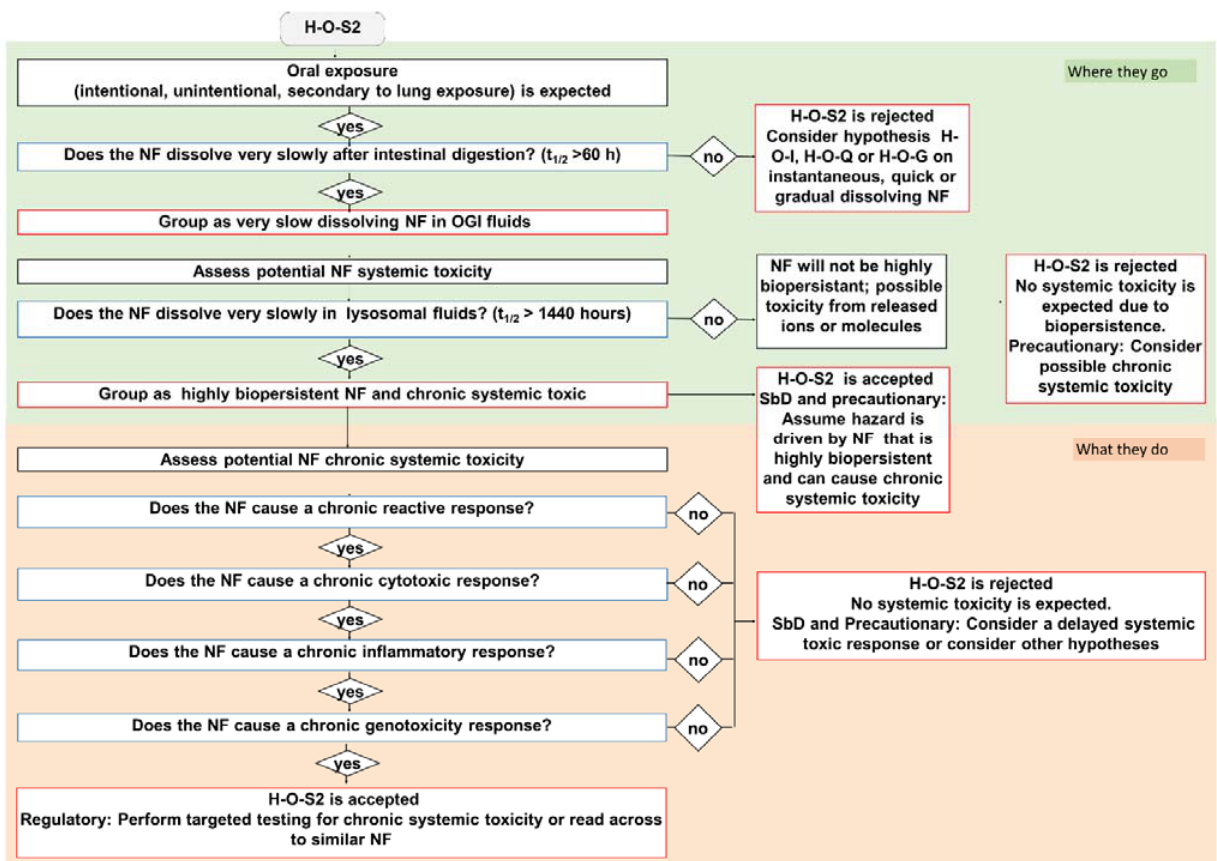
Figure 4. The IATA which addresses the oral ingestion hypothesis H-O-S2: Following oral exposure, NFs will maintain nanospecific activity that may drive translocation across the intestinal wall, subsequent biopersistence in the body and systemic toxicity in secondary organs. Blue bordered boxes are decision nodes, red bordered boxes are hypothesis conclusions, black bordered boxes are considerations.